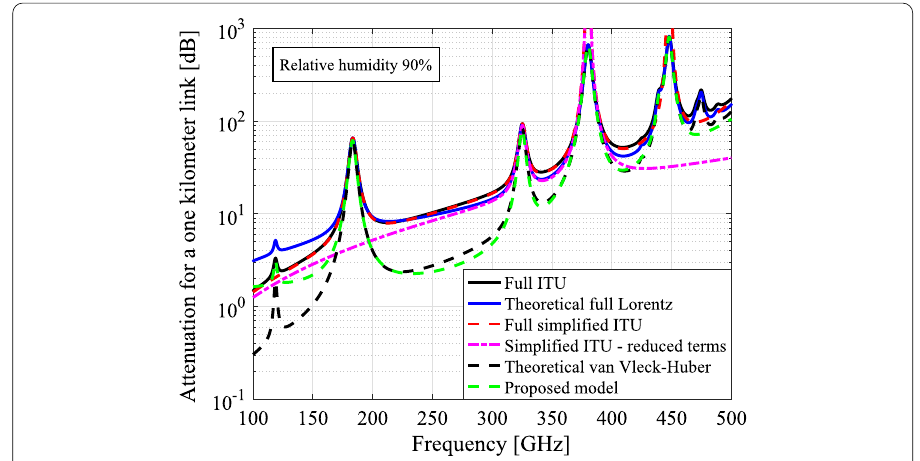
Fig. 4 Molecular absorption loss at 1 km distance and 90% relative humidity. Molecular absorption loss at 1 km distance at 25 degrees centigrade and 90% relative humidity ( µ = 0.0282 )